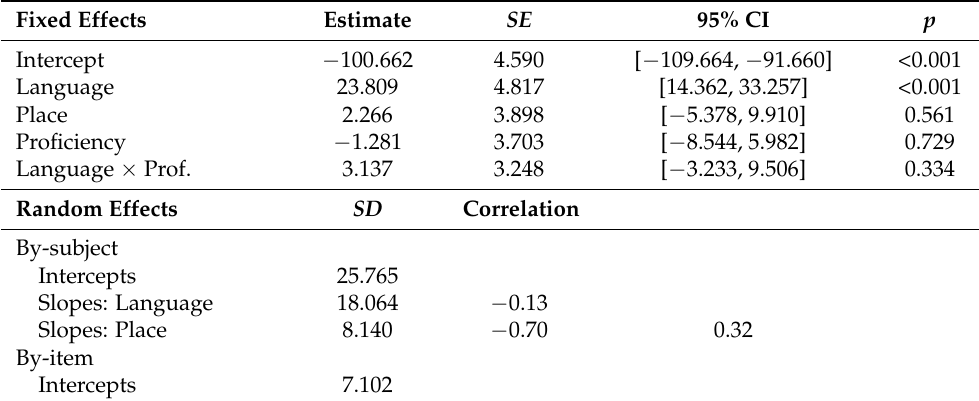
Table 3. Summary of linear mixed-effects model fit to the prevoiced stop